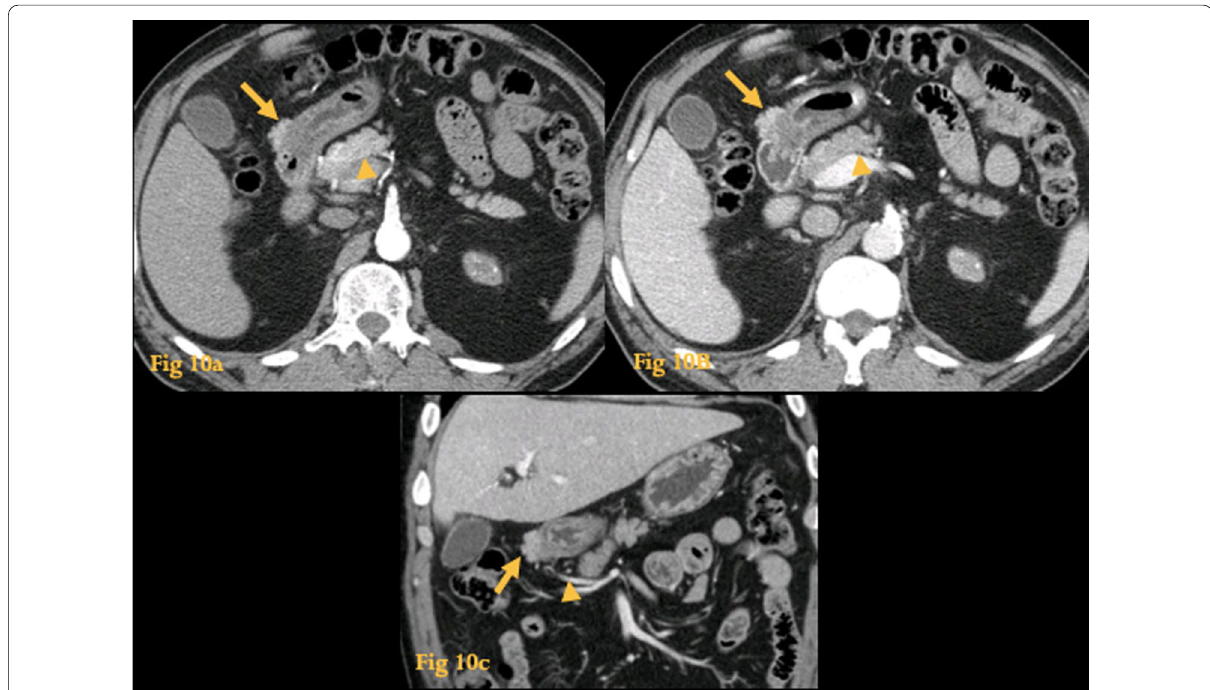
Fig. 10 Ectopic pancreas. Abdominal CT of a patient who underwent the exam for an unrelated reason. A soft‑tissue nodule, with a flat‑ovoid shape and microlobulations, is seen in the serosa of the first portion of the duodenum. It has an enhancement pattern similar to that of the normal pancreatic tissue (arrowheads on a , b ) in the late arterial ( a ) and portal venous phases ( b ). The lesion (arrow) is supplied by a branch of the gastroduodenal artery (arrowhead on c ). This was heterotopic pancreatic tissue in the duodenal bulb